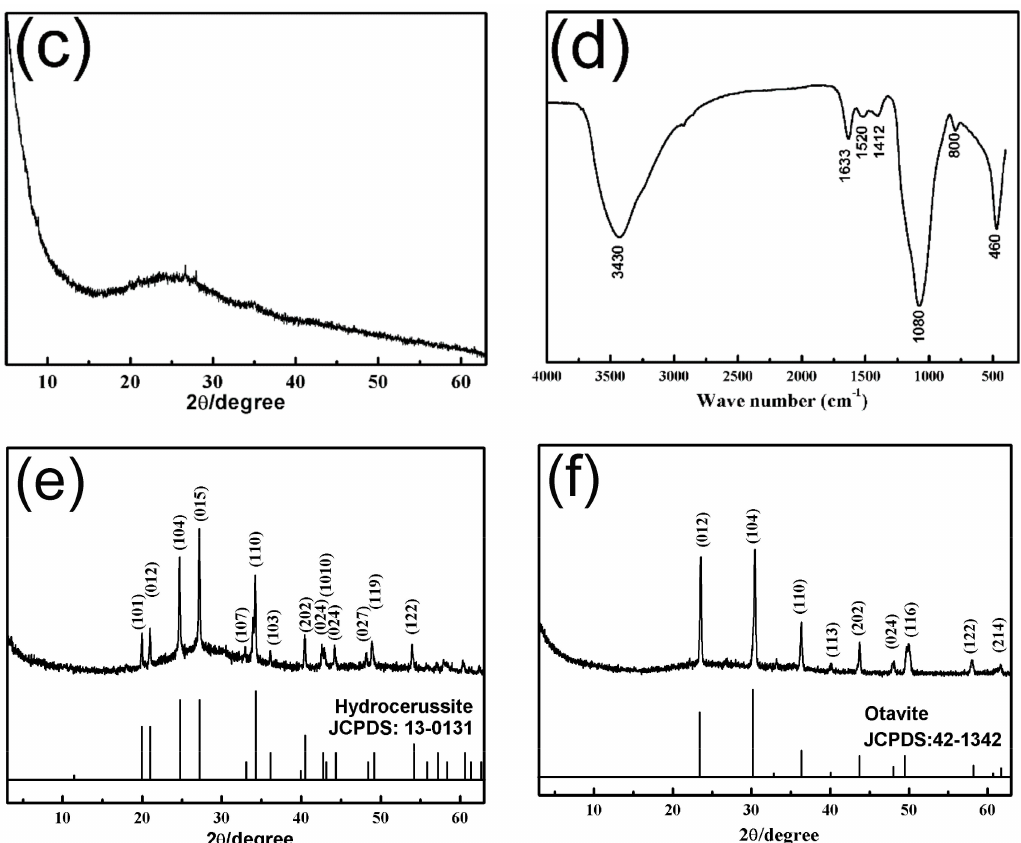
Figure 7. FESEM ( a ) and TEM ( b ) images, XRD pattern ( c ), and FTIR spectrum ( d ) of Gd(III)-loaded